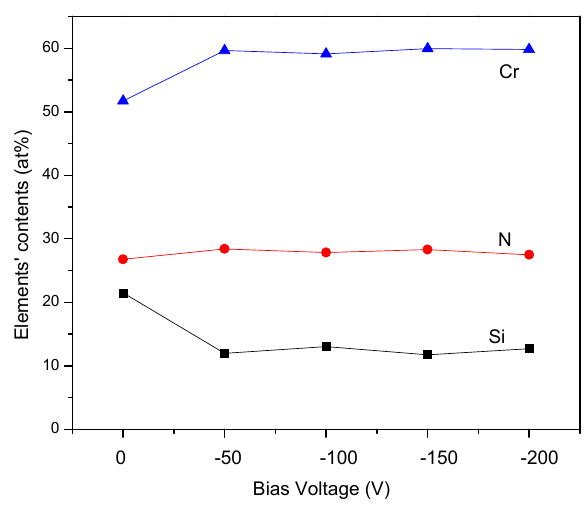
ff erent bias voltages.